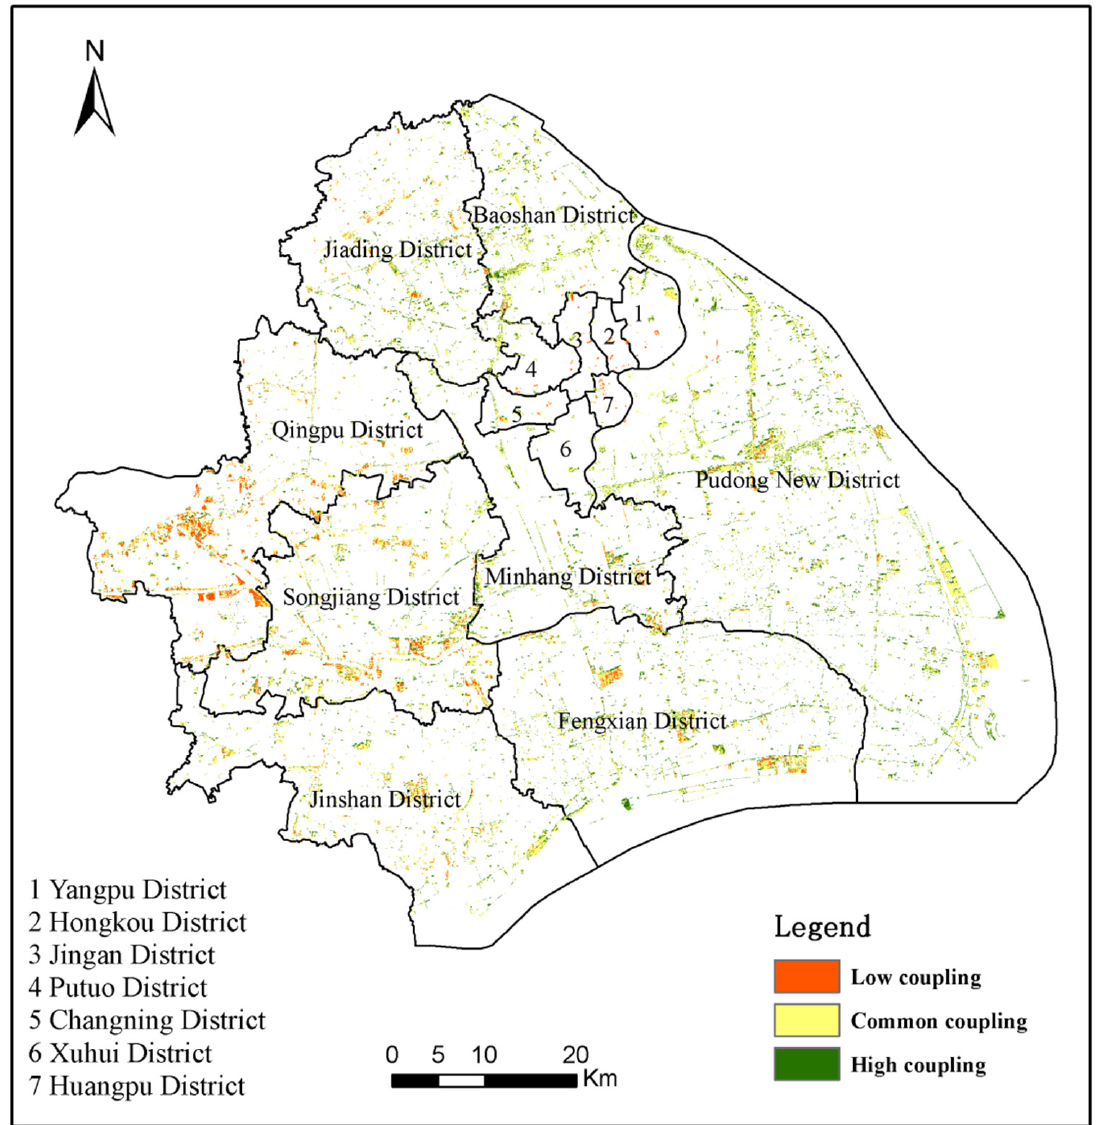
Figure 7. Coupling degrees between removal capacity of urban forests and PM 2.5 concentration.